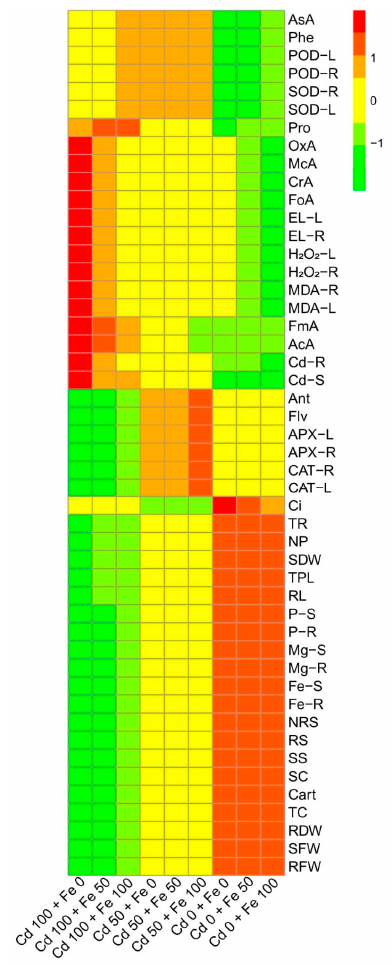
Figure 9. Heatmap histogram correlation between Cd uptake / accumulation with di ff erent morpho-physio-biochemical attributes of Oryza sativa grown under di ff erent levels of Cd stress (0, 50, and 100 µ M) with di ff erent concentrations of exogenous application of FeSO 4 (0, 50, and 100 µ M). Di ff erent abbreviations used are as follow: Ci (intercellular CO 2 ), P-S (phosphorus contents in the shoots), P-R (phosphorus contents in the roots), Mg-S (magnesium contents in the shoots), Mg-R (magnesium contents in the roots), Ca-S (calcium contents in the shoots), Ca-R (calcium contents in the roots), Fe-S (iron contents in the shoots), Fe-R (iron contents in the roots), NRS (non-reducing sugars), RS (reducing sugars), SS (soluble sugars), TR (transpiration rate), SC (stomatal conductance), NP (net photosynthesis), Carot (carotenoid contents), TC (total chlorophyll), RDW (root dry weight), SDW (shoot dry weight), RFW (root fresh weight), SFW (shoot fresh weight), TPL (total plant length), RL (root length), Ant (anthocyanin contents), AsA (ascorbic acid contents), Flv (flavonoid contents), Phe (phenolic contents), APX-L (ascorbate peroxidase activity in the leaves), APX-R (ascorbate peroxidase activity in the roots), CAT-L (catalase activity in the leaves), CAT-R (catalase activity in the roots), POD-R (peroxidase activity in the roots), POD-L (peroxidase activity in the leaves), SOD-R (superoxidase dismutase activity in the roots), SOD-L (superoxidase dismutase activity in the leaves), Pro (proline contents), OxA (oxalic acid contents), McA (melic acid contents), CrA (citric acid contents), AcA (acetic acid contents), FoA (formic acid contents), FmA (fumaric acid contents), EL-L (electrolyte leakage in the leaves), EL-R (electrolyte leakage in the roots), H 2 O 2 -L (hydrogen peroxide initiation in the leaves), H 2 O 2 -R (hydrogen peroxide initiation in the roots), MDA-R (malondialdehyde contents in the roots), MDA-L (malondialdehyde contents in the leaves), Cd-R (Cd concentration in the roots), and Cd-S (Cd concentration in the